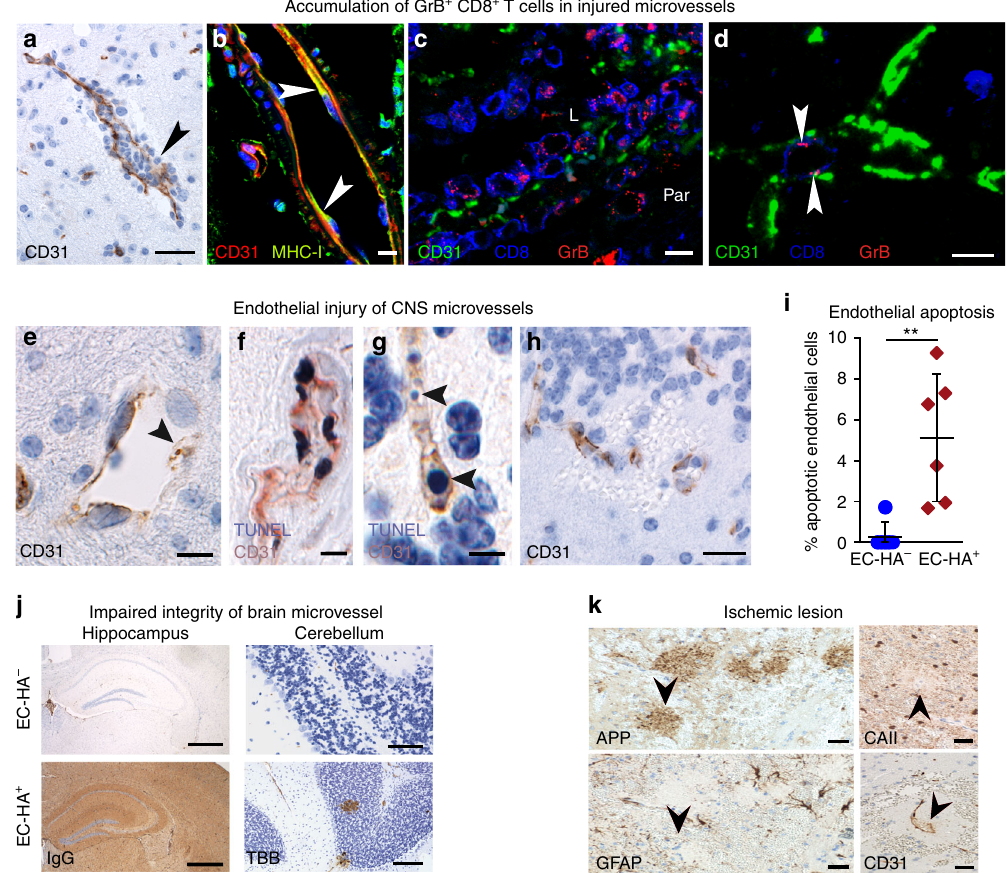
Fig. 6 CTLs accumulate in damaged microvessels of EC-HA + mice. Representative brain images of EC-HA + mice 4 days after adoptive transfer of cytotoxic CD8 + T cells ( n = 6). a Accumulation of leukocytes in CNS microvessels. b Expression of MHC class-I molecules (green) on CD31 + (red) ECs; nuclei marked with TO-PRO-3 (blue). c Presence of GrB + (red) CD8 + (blue) T cells in vessel lumen (L) of a battered CD31 + (green) blood vessel. Par parenchyma d GrB + granules (red, arrowheads) CD8 + cells (blue) in close contact with the lumen of a small CD31 + blood vessel (green). e Representative image exhibiting CD31 + (brown) endothelium loss (arrowheads) in CNS microvessels of EC-HA + mice following CD8 + T cell transfer. f Apoptosis and g DNA fragmentation (arrowheads) of CD31 + ECs (brown) detected with TUNEL staining (black). h Microhemorrhages in close proximity to destroyed vessels. Scale bars 10 µ m. i Percentage of endothelial apoptosis assessed condensed nuclei in CD34 + endothelial cells (74 – 206 cells per mouse) of EC-HA − (closed blue circles) or EC-HA + mice (closed cayenne diamonds) ( n = 6 per group). Scale bars 100 µ m. Statistical analysis was performed by unpaired Student ’ s t test. Error bars indicate the mean ± s.d. p value: ** p < 0.01. Source data are provided as a Source Data fi le. j Deposition of IgG in